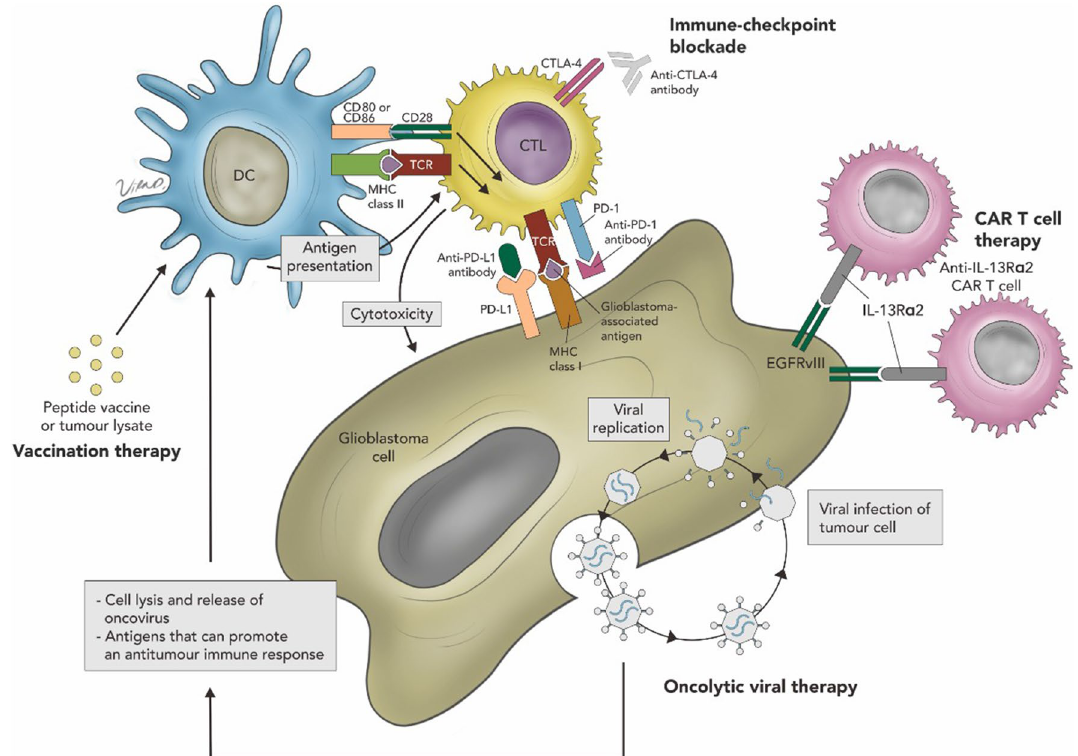
Fig. 2 Mechanism of CAR T-cell therapy. The figure shows an illustration of combining CAR T-cell therapy with oncolytic viruses or